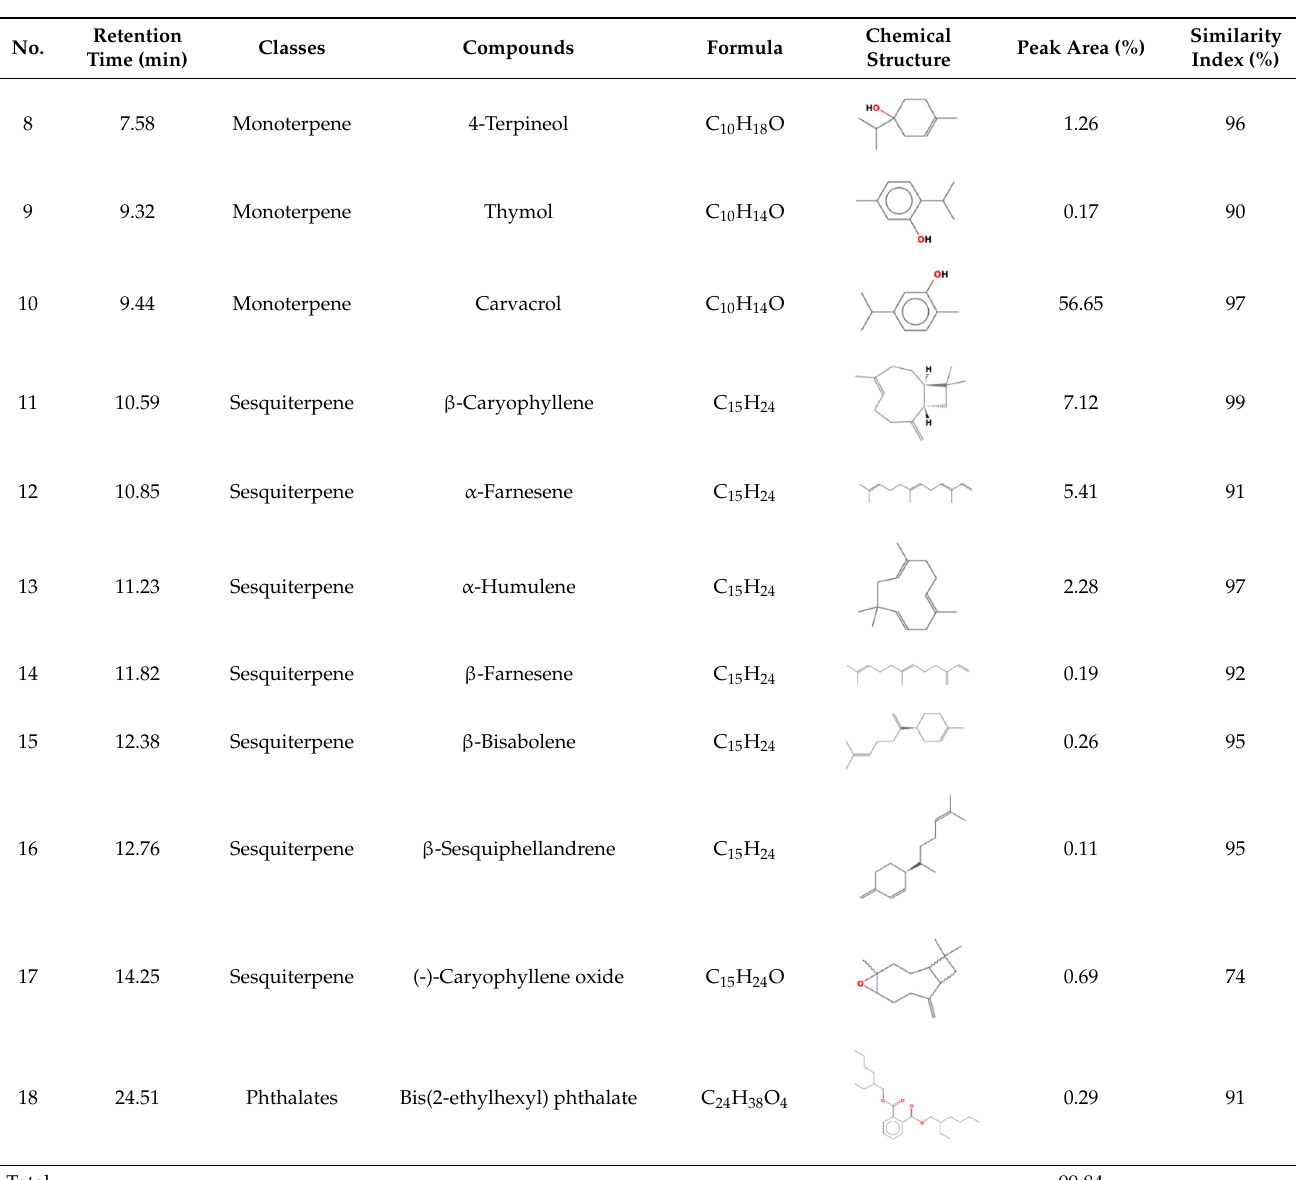
The yield of CEE was 2.2% w / w , appearing as a dark green and highly viscous solid. The total phenolic content was 666.0 ± 9.1 mg gallic acid equivalent (GAE)/g sample and the total flavonoid content was 462.3 ± 3.1 mg quercetin equivalent (QE)/g sample. The three compound standards, namely rosmarinic acid, apigenin, and caffeic acid, were qualified via high-performance liquid chromatography ([HPLC]; Figure 2). The concentrations of rosmarinic acid, apigenin, and caffeic acid used for quantification were 1.251, 1.175, and 0.732 mg/g samples, respectively (Table 2).